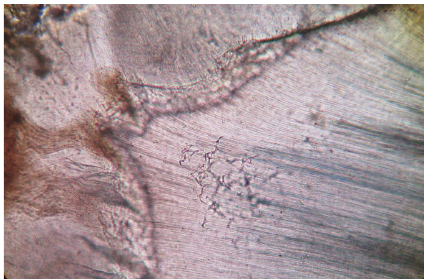
Figure 7: Interglobular dentine (photomicrograph, ground section 10x).